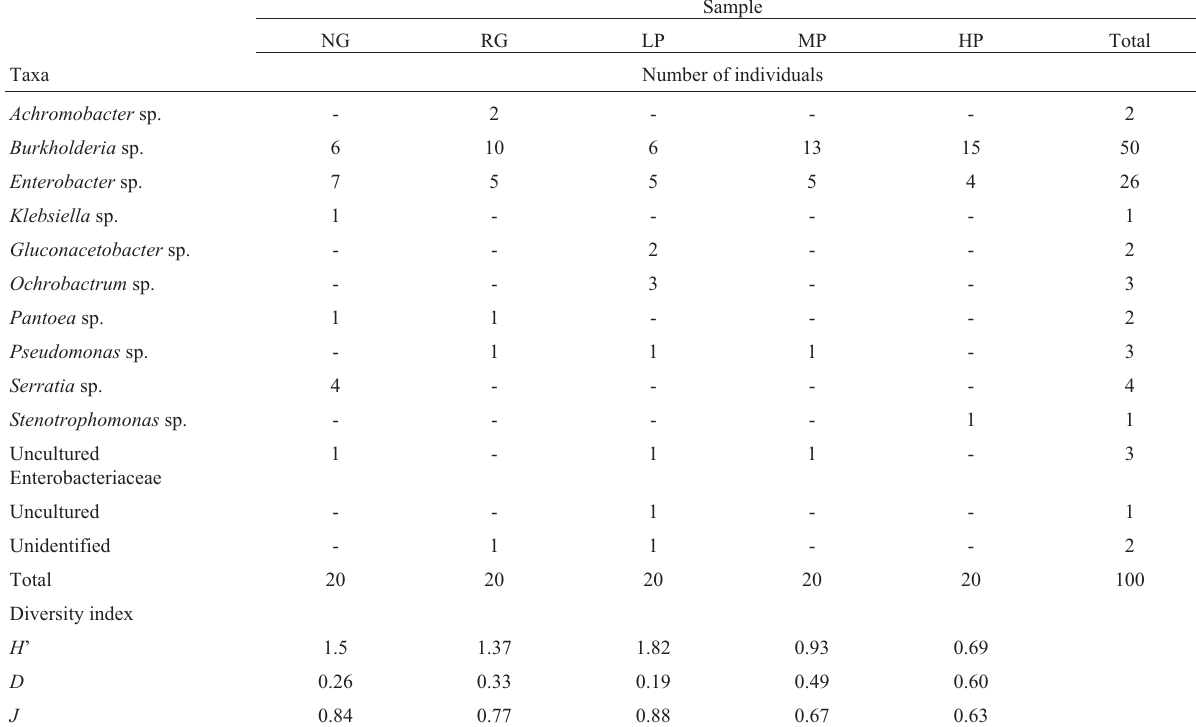
Table 3 - Diversity of diazotrophic bacteria in soil under different grazing